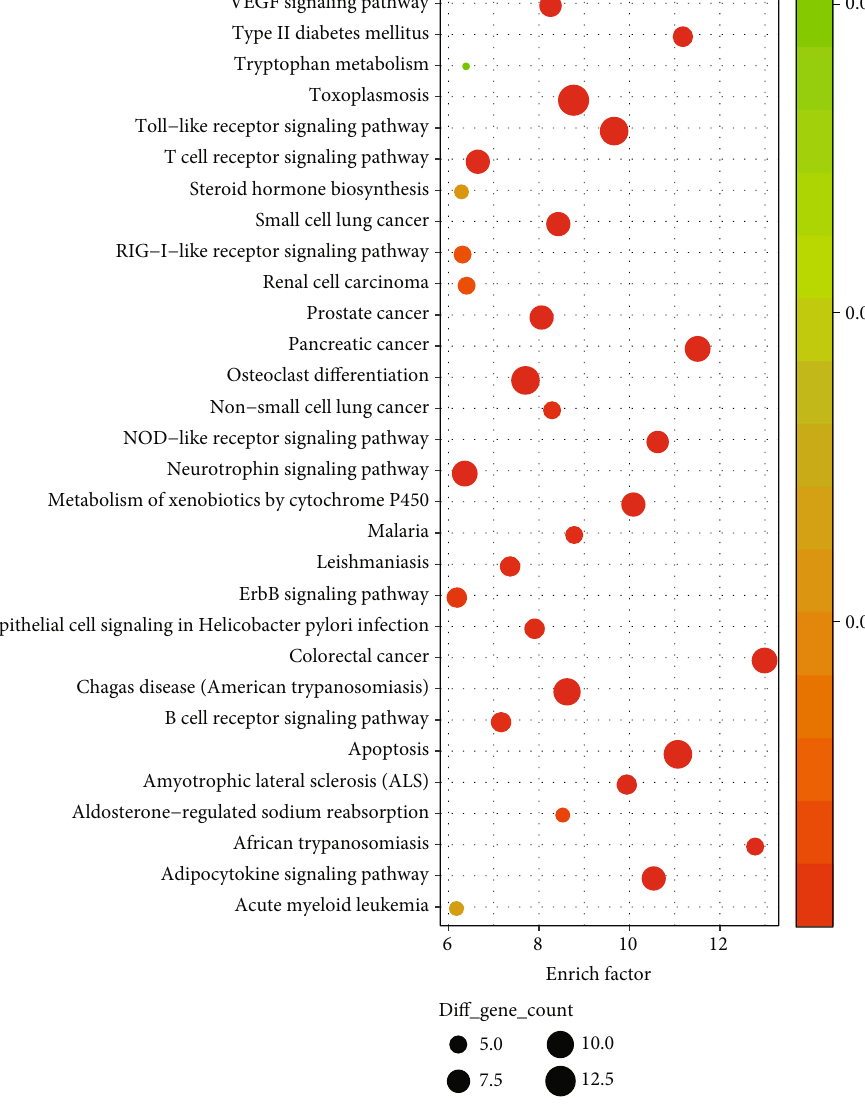
Figure 3: KEGG-enriched bubble